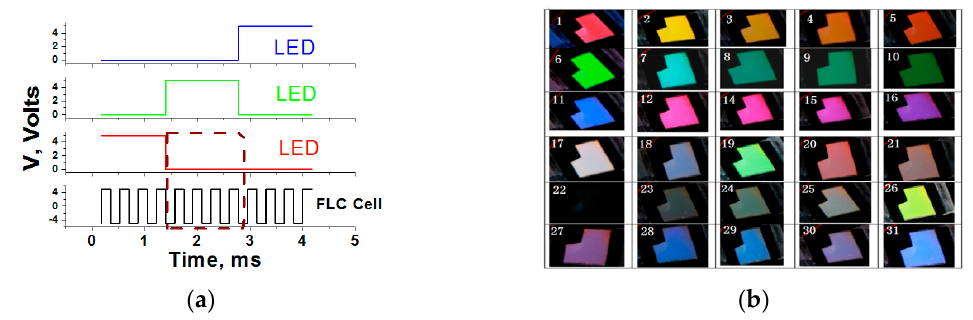
Figure 20. ( a ) Driving scheme for ESH FSC. Top three are the waveforms applied to three sequential